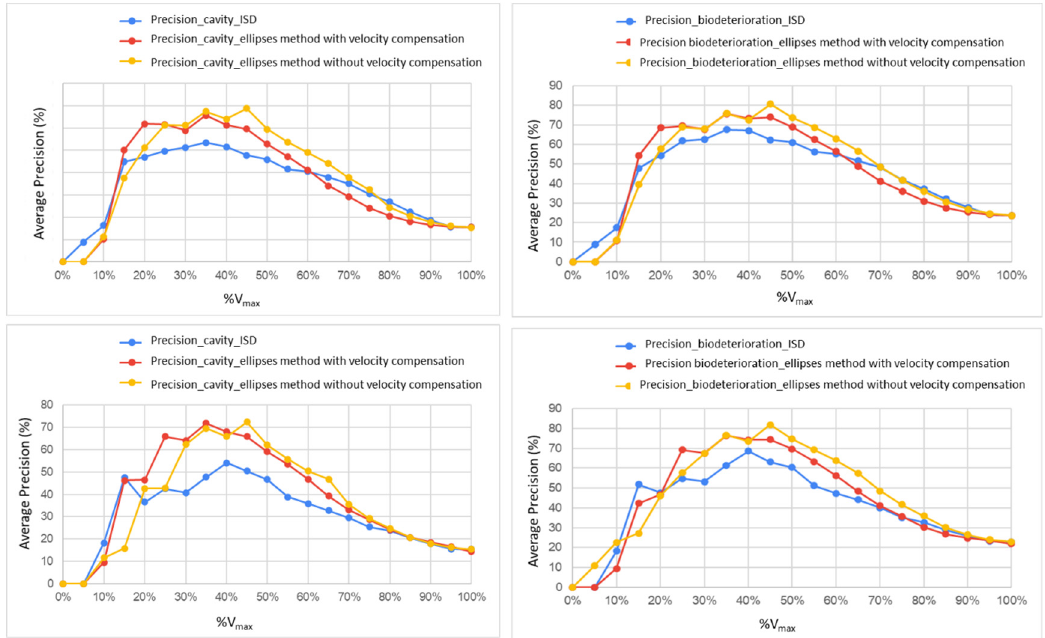
Figure 12. Behavior of the precision metric, obtained with the application of the confusion matrix for the cavity and the cavity plus biodeterioration as zones of interest, without the application of filters (upper graphs) and with the application of filters (lower graphs).